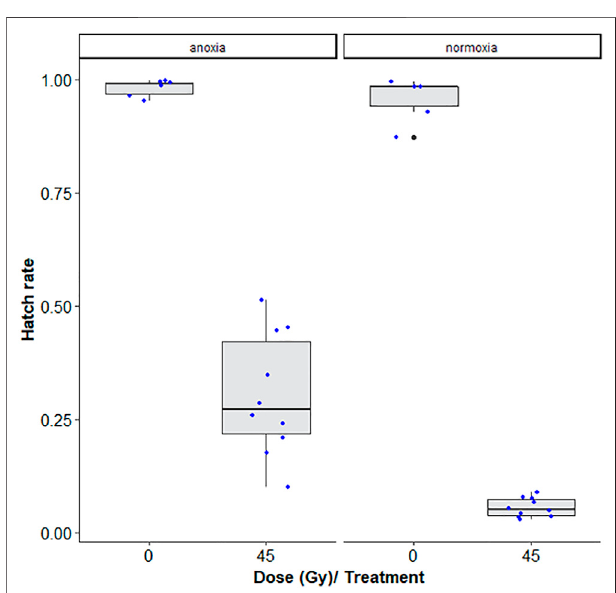
FIGURE 5 | Longevity of chilled versus non-chilled Aedes albopictus males irradiated at 45 Gy as either pupae (A) or as adults (B) , compared to non-irradiated controls. TABLE 4 | Fixed coef fi cients of the effects of adult chilling on male Ae. albopictus longevity. coef exp (coef)